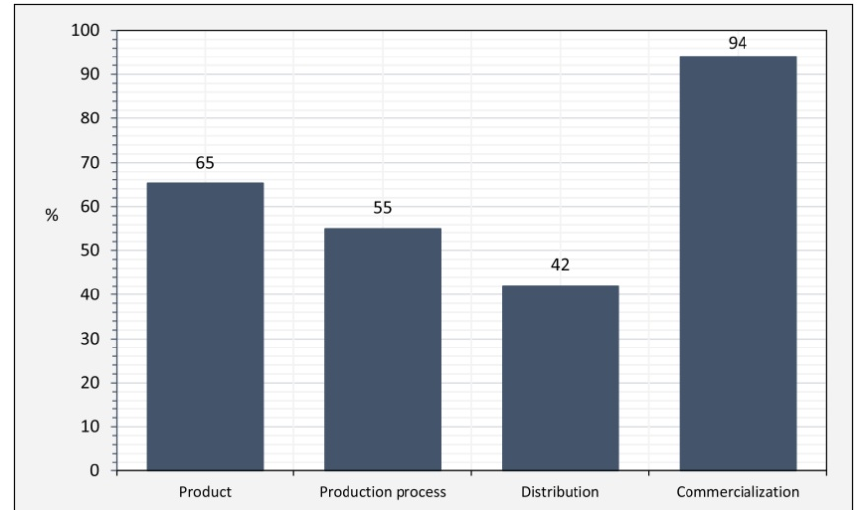
Figure 5. Aspects in which the projects introduced innovations (%).